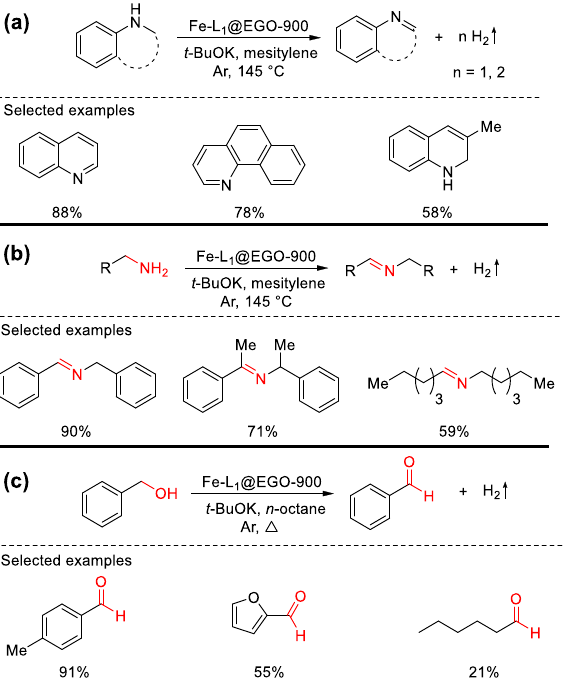
Figure 18. Schematic diagram of the synthesis of Fe@CN-800 and its catalyzed acylation reaction. Reprinted with permission from Ref. [94]. Copyright 2019, Royal Society of Chemistry.